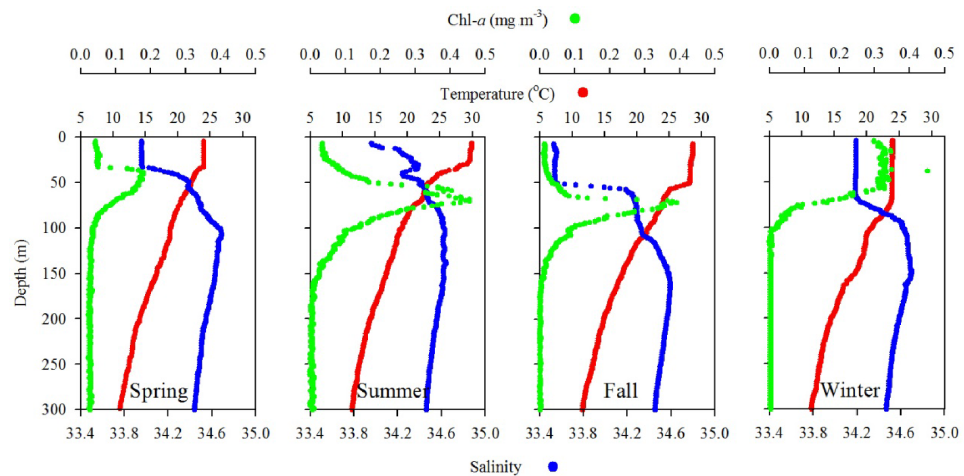
Figure 4. Comparison of seasonal variations of temperature, salinity, and fluorescence (Chl a ) profiles in the upper layer (300m) of the water column at SEATS (11) station.